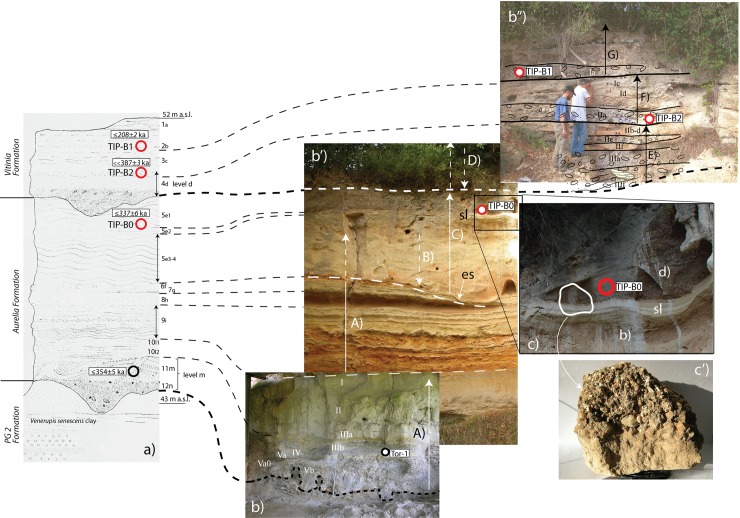
Composite stratigraphy of the Torre in Pietra sections.Photographs show the refreshed Upper and Lower sections with layers labeled according to the present study and with position of the samples dated by 40Ar/39Ar method (red circles: this work; black circle: [24]). Layers as labeled in [1] are reported besides the stratigraphic scheme, along with the revised elevations, as inferred from the topographic survey in [29] (Fig C in S1 File). Capital letters indicate phases of sediment aggradation (A, C, E, F, G) and intervening regressive phases (B, D), corresponding to as many sea-level oscillations. The left panel of the figure is modified after [1] with permission by the Italian Institute of Human Paleontology (S4 File).